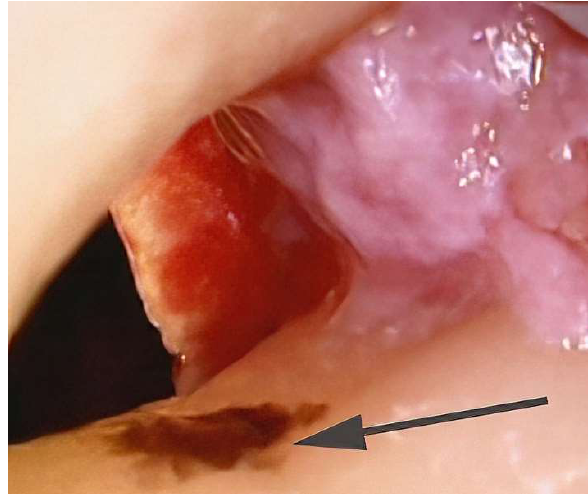
Figure 3. During osseous surgery an area of calculus (arrow) missed during SRP is shown in a concavity on the root surface. Due to the anatomy of the root, this calculus would be very difficult to remove without direct visualization. (Videoscope photo 40× magnification).